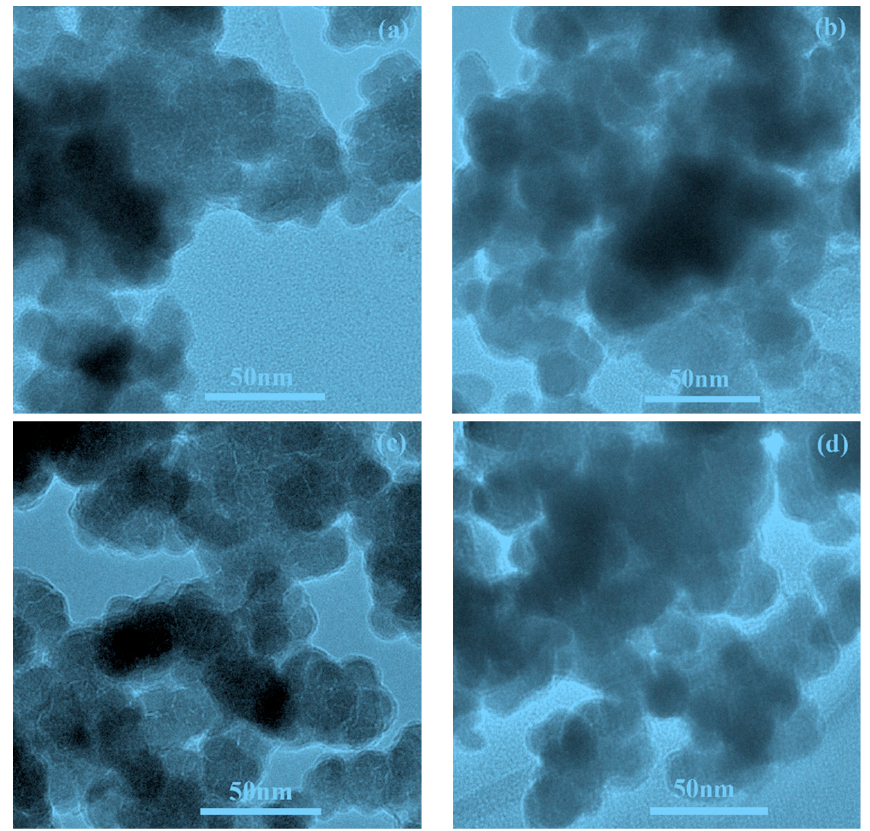
Figure 1. TEM images of ( a ) Ni-B, ( b ) Ni-B-Co 0.02 , ( c ) Ni-B-Co 0.05 , and ( d ) Ni-B-Co 0.1 nanoparticles.